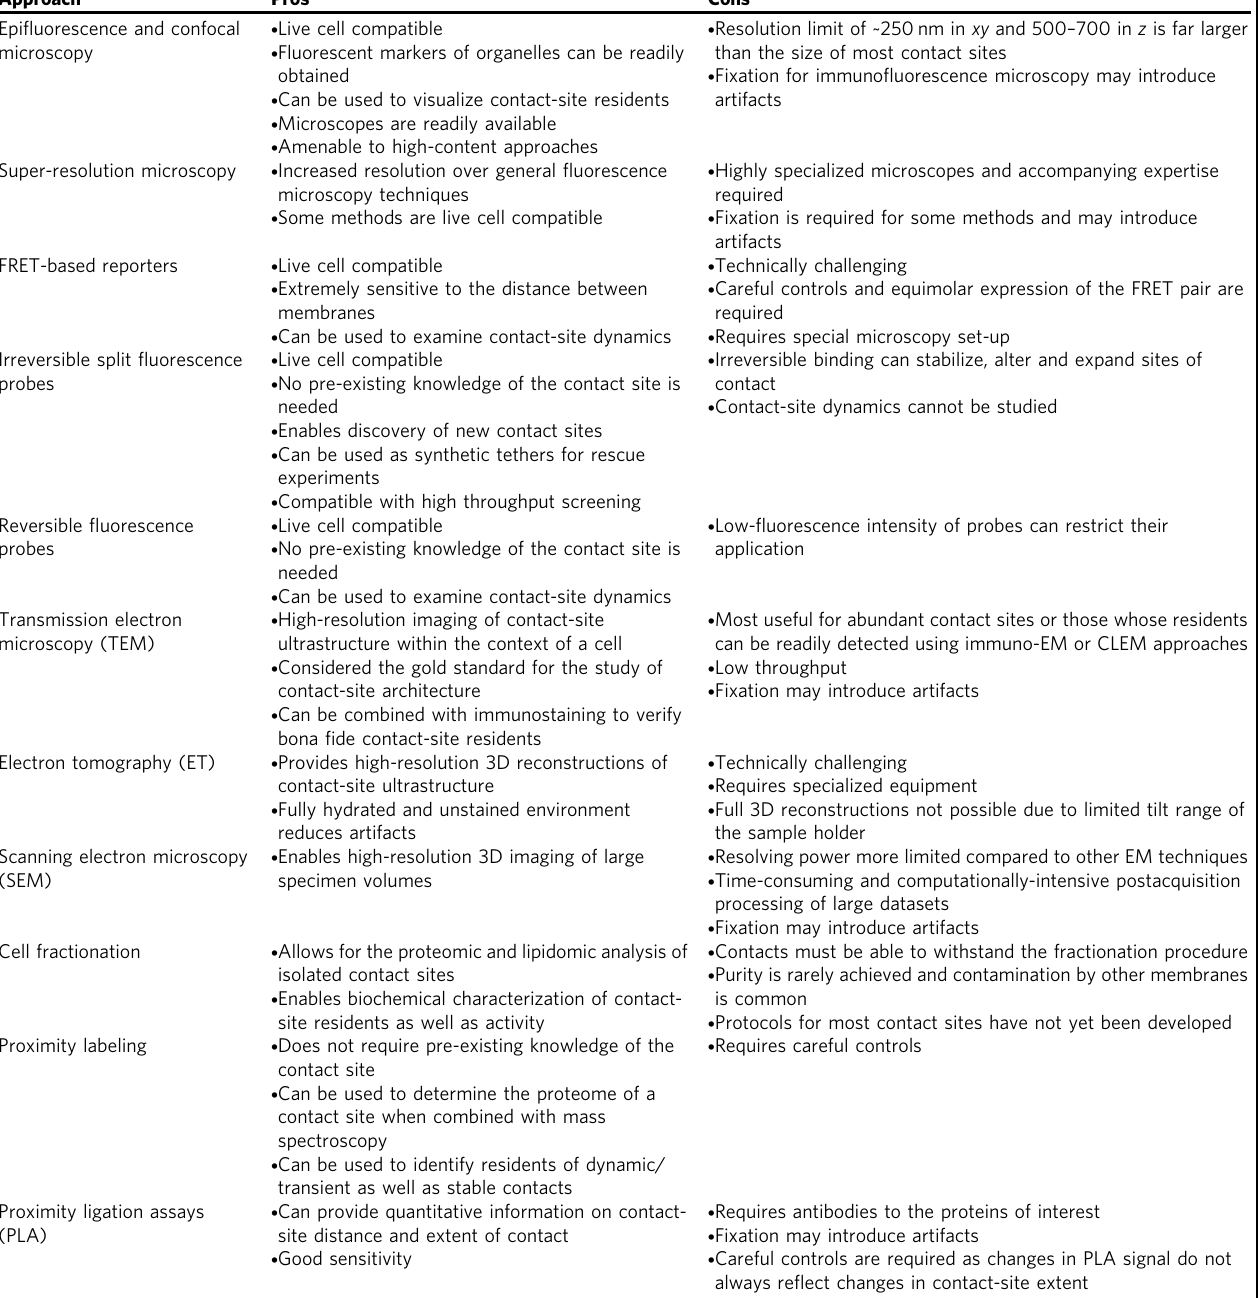
Table 1 Pros and cons of the various experimental approaches to study contact sites Approach Pros